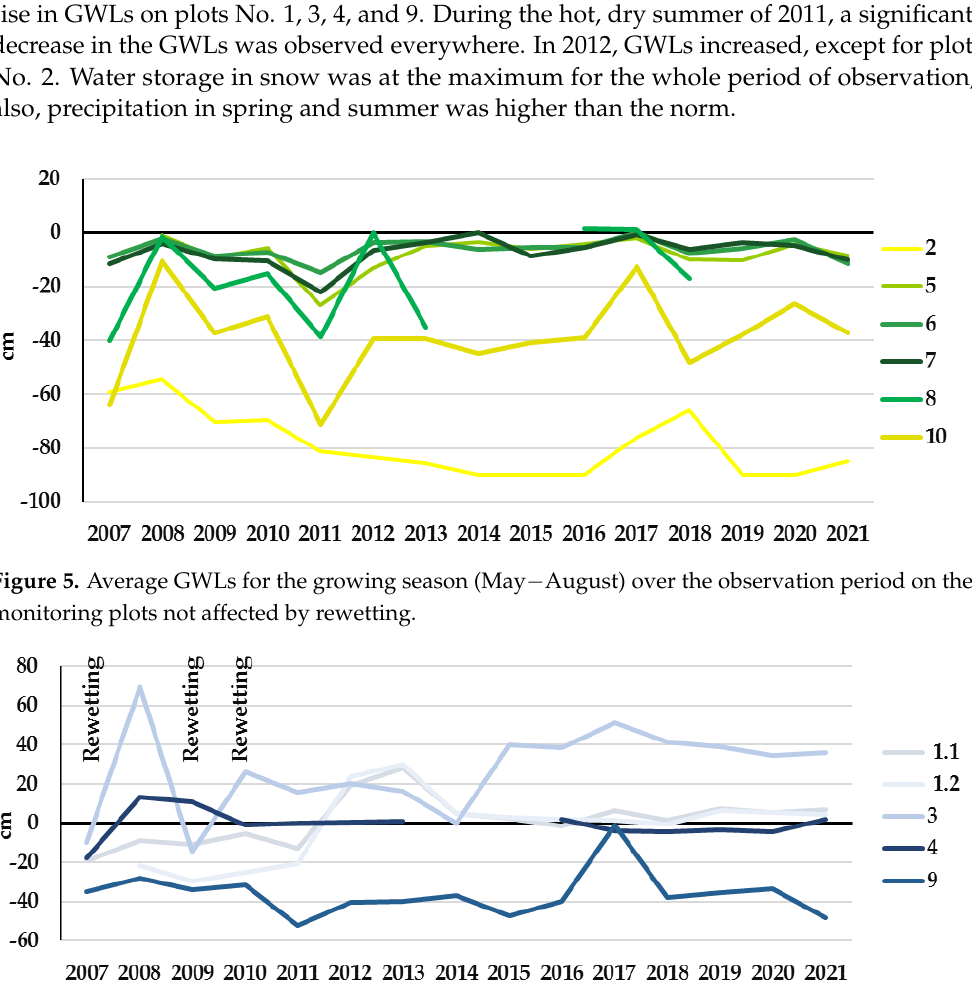
Figure 6. Average GWLs during the growing season (May − August) for the observation period on the monitoring plots affected by rewetting.